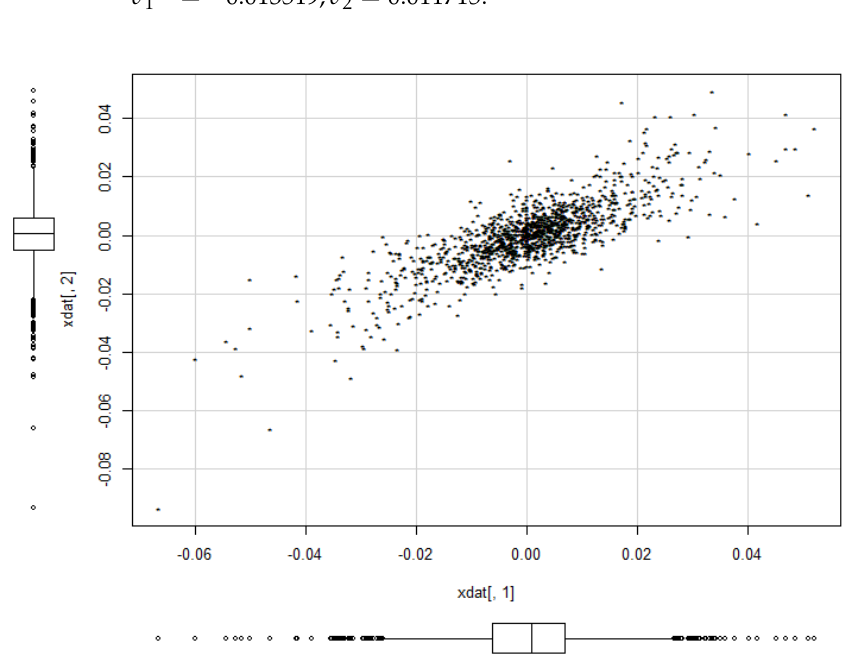
Figure 12. Scatter plot of the MSCI